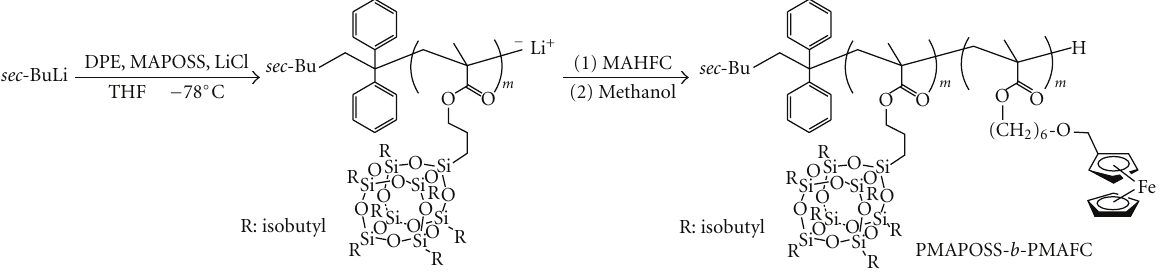
Figure 3: Synthesis of PMAPOSS- b -PMAHFC by living anion polymerization.